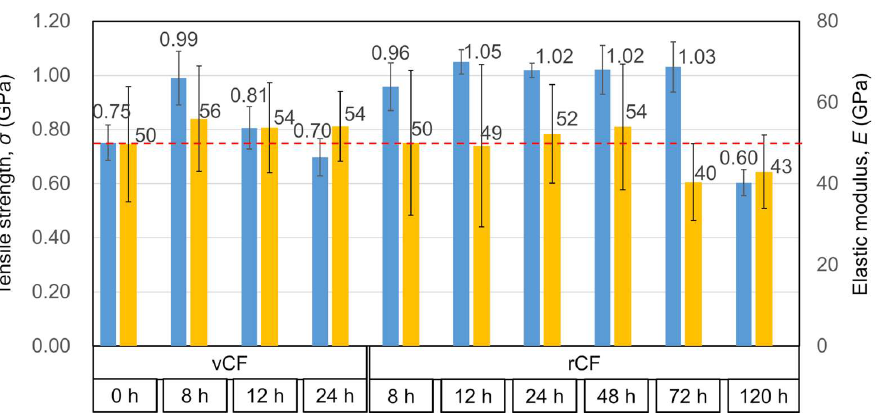
Figure 5. Tensile strength and elastic modulus obtained by tensile test for vCF, vCF 8 h–24 h, and rCF 8 h–120 h.